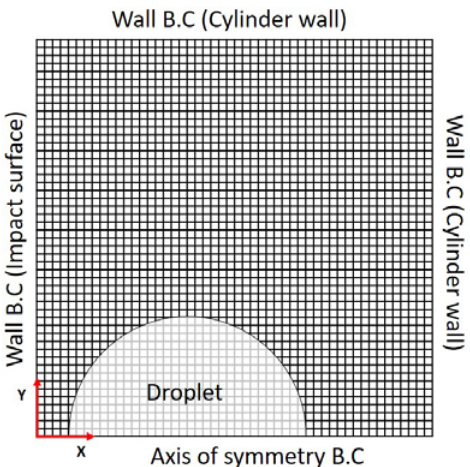
Figure 1. Numerical domain of the axisymmetric model for a droplet traveling from right to left (showing a very unrefined mesh).